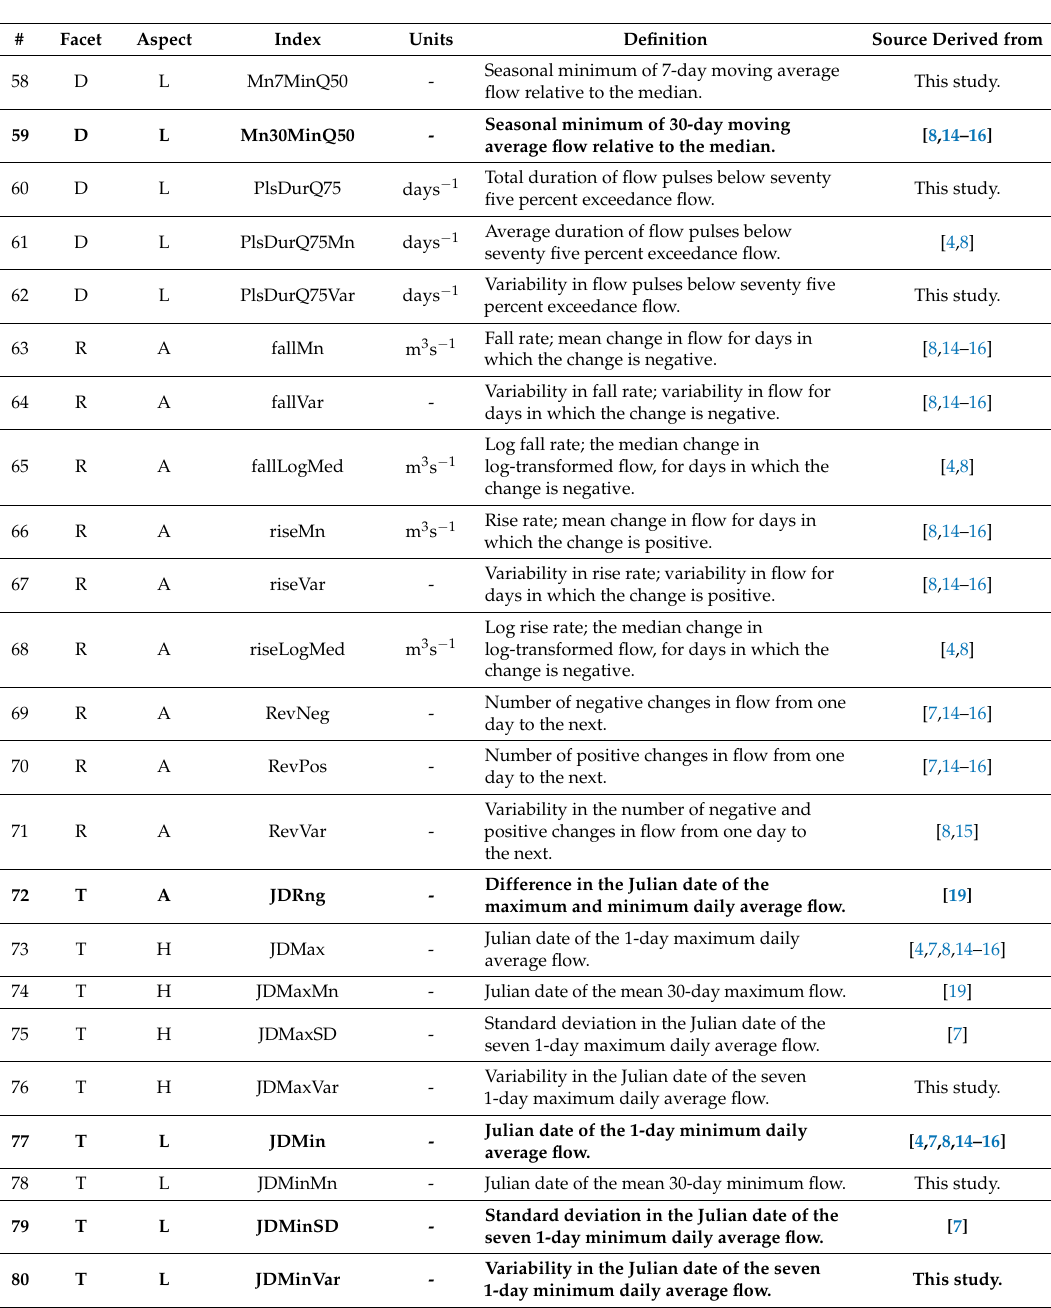
Source Derived from This study. This study.